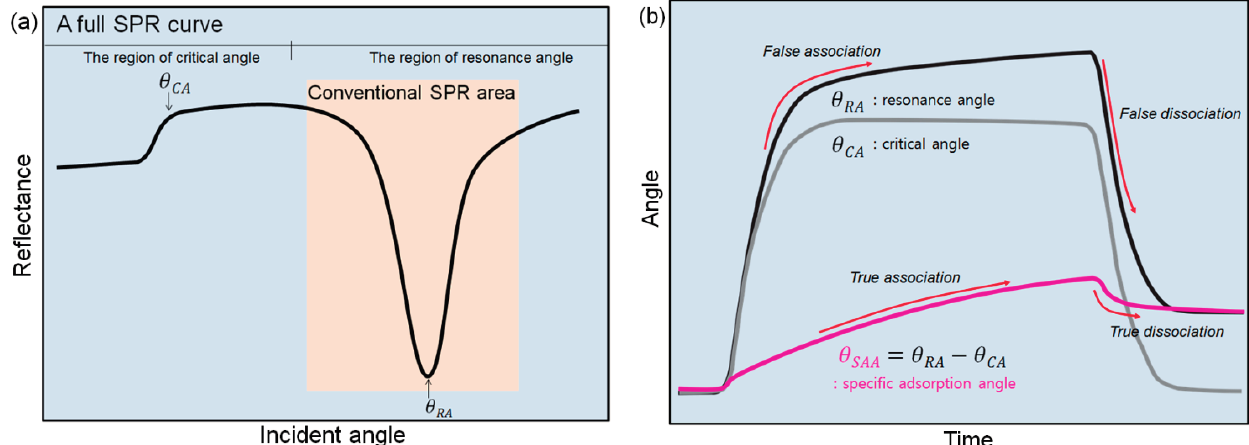
) and (cid:3019)(cid:3002)